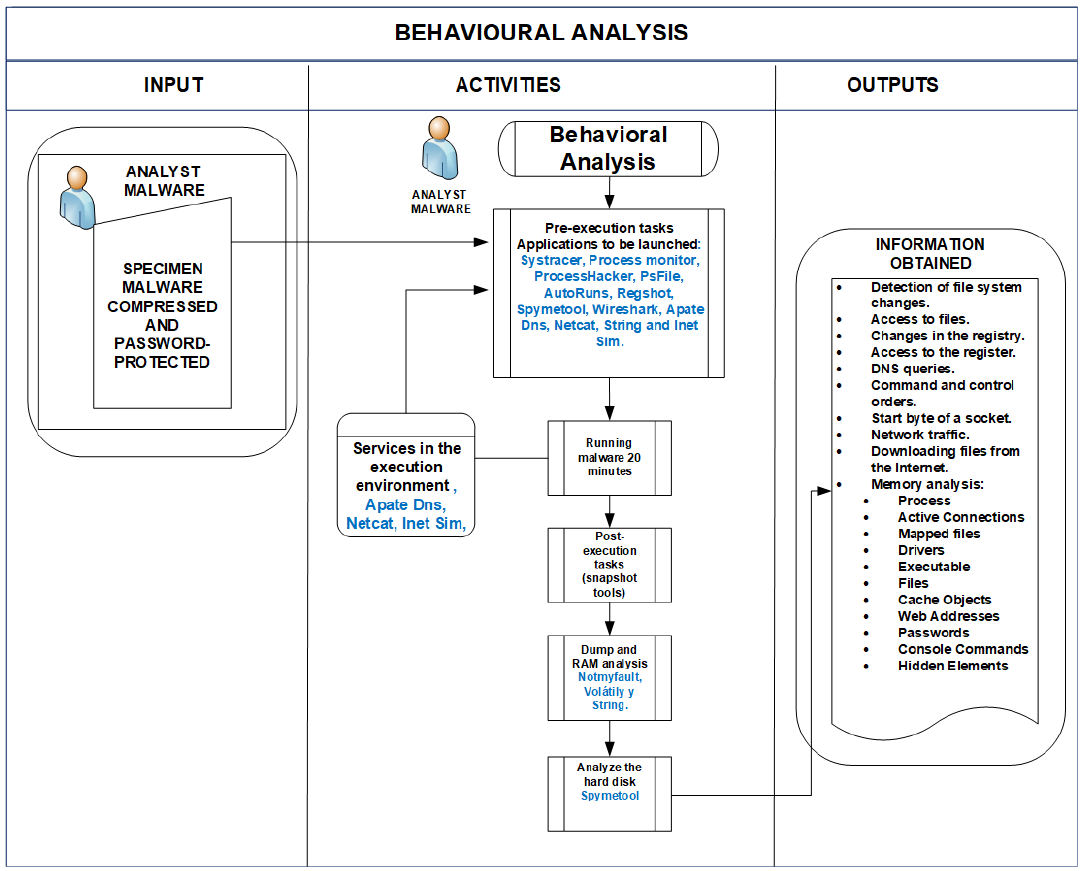
Figure 8. Diagram of the behavioral analysis step.